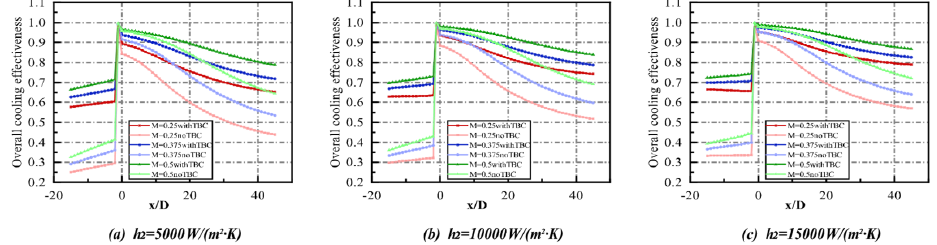
Figure 7. Distribution of 𝜂 with or without TBC at different BR and h 2 at γ (cid:3404) 9 .